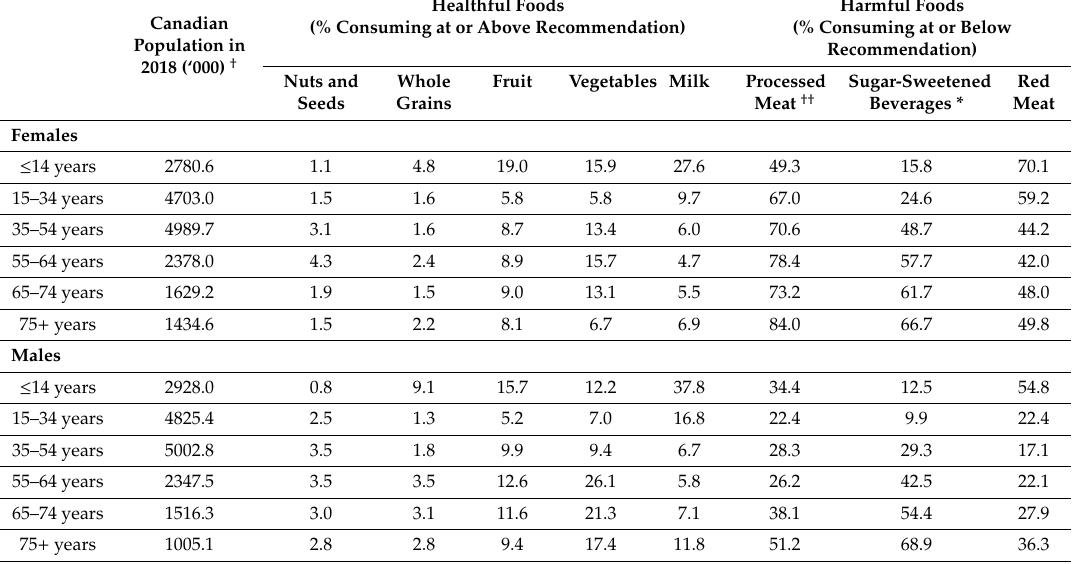
Table 2. Food recommendation adherence percentages of 2015 Canadian population stratified by age and